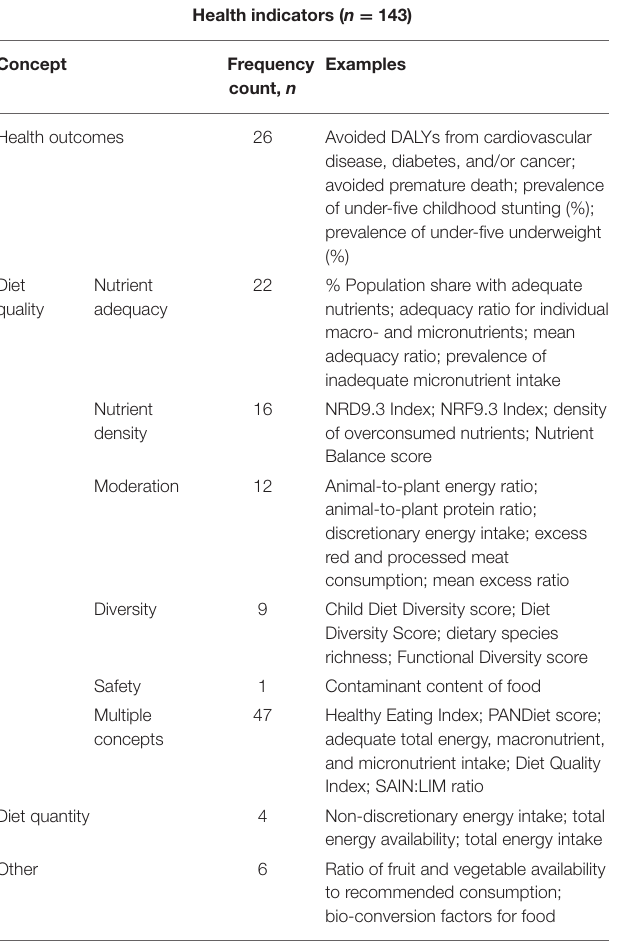
TABLE 1 | Health indicators by concept measured and frequency of use in the scoping review.